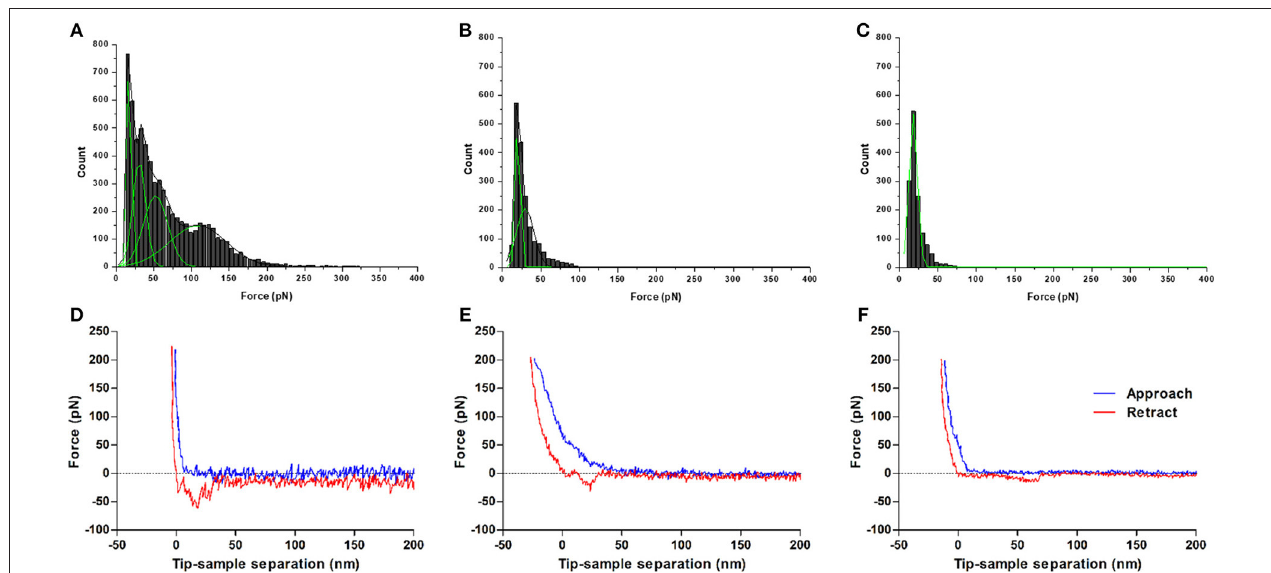
FIGURE 2 | Force rupture histograms of WNV C-LDs binding, obtained by AFM-based force spectroscopy. Experiments were performed in TEE buffer with 100mM KCl (A) , 10mM KCl (B) or 100mM NaCl (C) . The stronger and specific interaction forces between WNV C and LD are only found at K + concentrations similar to the intracellular environment. Only weak interactions, characteristic of unspecific binding, are observed for low potassium ion concentrations or in its absence. Gaussian fitting lines of each individual peak (green) and cumulative fit lines of the histogram (black) are presented. Examples of approach-retraction curves acquired during the force spectroscopy measurements of WNV C-LDs adhesion in TEE buffer with 100mM KCl (D) , 10mM KCl (E) , or 100mM NaCl (F)